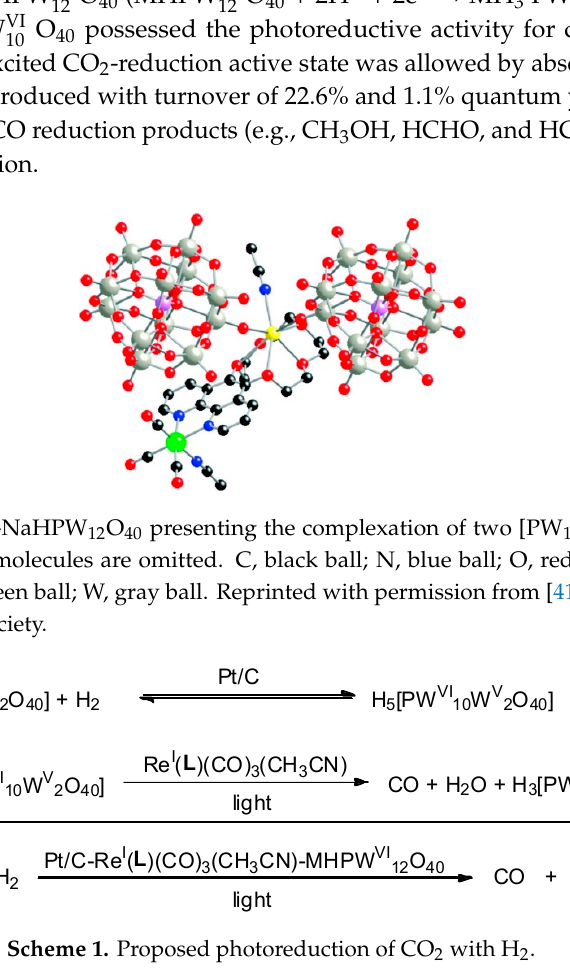
Figure 4. Re I (L)(CO) 3 -NaHPW 12 O 40 presenting the complexation of two [PW 12 O 40 ] 3– units to Na. H atoms and solvent molecules are omitted. C, black ball; N, blue ball; O, red ball; P, purple ball; Na, yellow ball; Re, green ball; W, gray ball. Reprinted with permission from [41]. Copyright© 2011 American Chemical